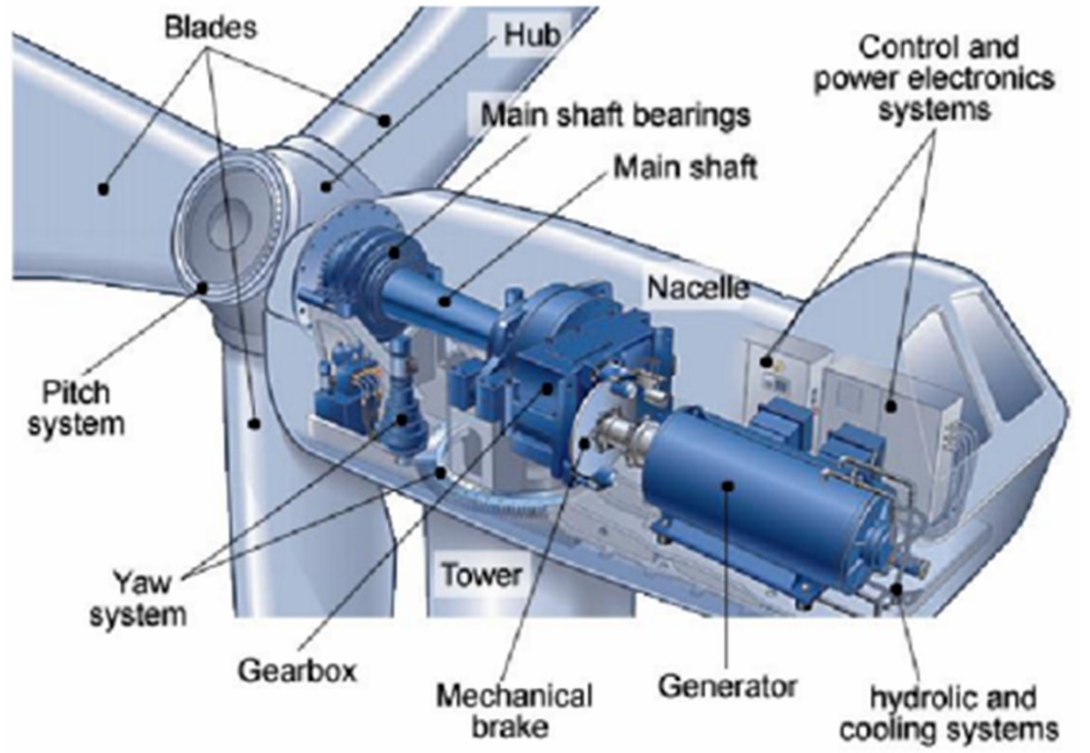
Figure 2. Wind turbine generator system [Reprinted/adapted with permission from Ref. [20]. 2013,